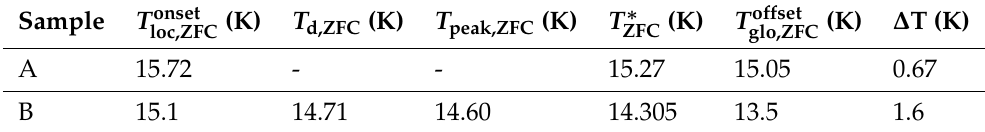
Figure 3. ZFC and FC ρ xx as a function of T under the application of µ 0 H ⊥ = 0 T, 1 T, 3 T, 5 T and 7 T measured for samples ( a ) #A and ( b ) #B. Transverse ρ xx as a function of µ 0 H ⊥ recorded at different T for samples ( c ) #A and ( d ) #B. Table 2. Characteristic temperatures of samples #A and #B recorded for ZFC ρ xx ( T )